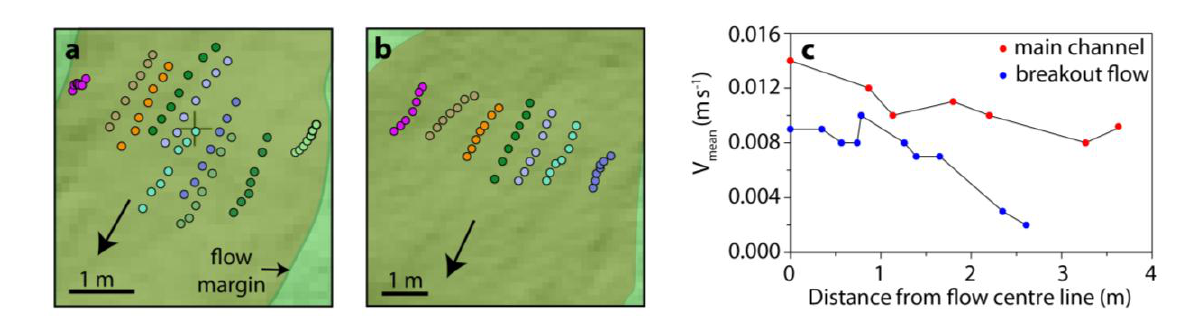
Figure 6. Flow feature displacements and mean surface velocities. Planimetric views of the re-projected point tracks on ( a ) the breakout flow and ( b ) the main channel (Regions 1 and 2 in Figure 5a). ( c ) The calculated mean velocities from the point displacements.